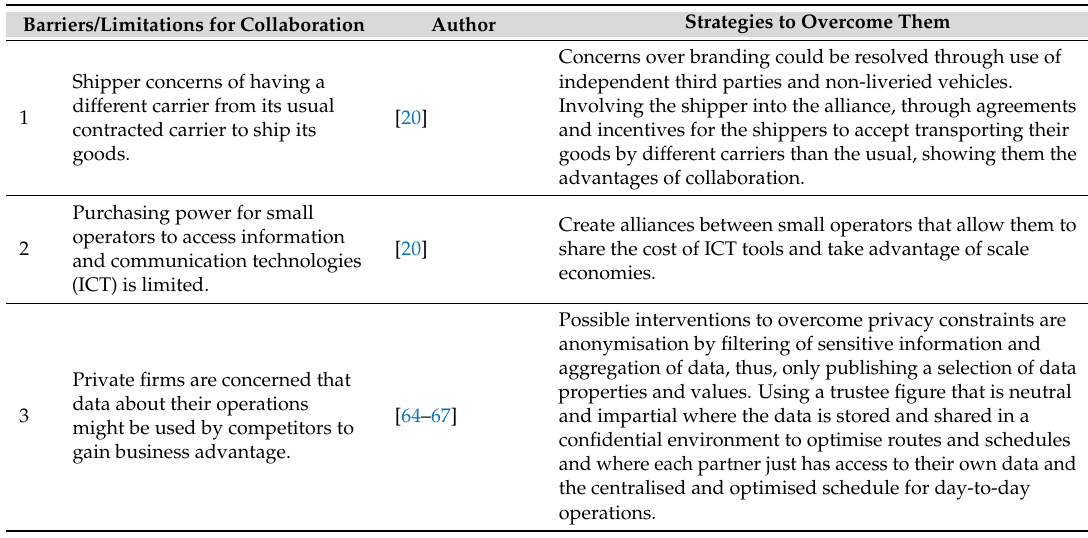
Table 3. Barriers for collaboration in the freight industry and strategies to overcome them. Barriers/Limitations for Collaboration